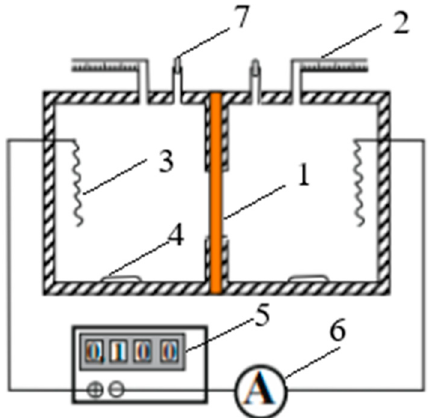
Figure 6. An electrical circuit and a cell for determining the water fluxes through the membrane: 1—the membrane under study, 2—measuring capillaries, 3—silver-silver chloride electrodes, 4—magnetic stirrers, 5—a DC source, 6—an ammeter, 7—funnels for filling the cell with a working solution.